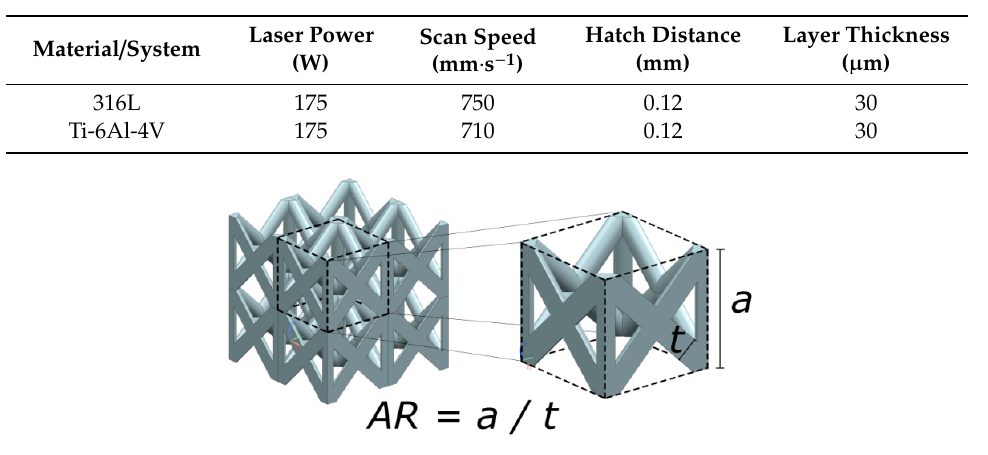
Figure 4. Aspect ratio of cellular lattice structures, exemplarily shown for an f2ccz structure.